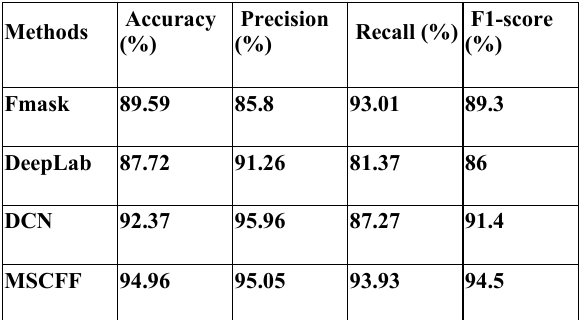
Table 7: Accuracy scores from other studies based on Landsat-8 scenes (Li et al., 2019).